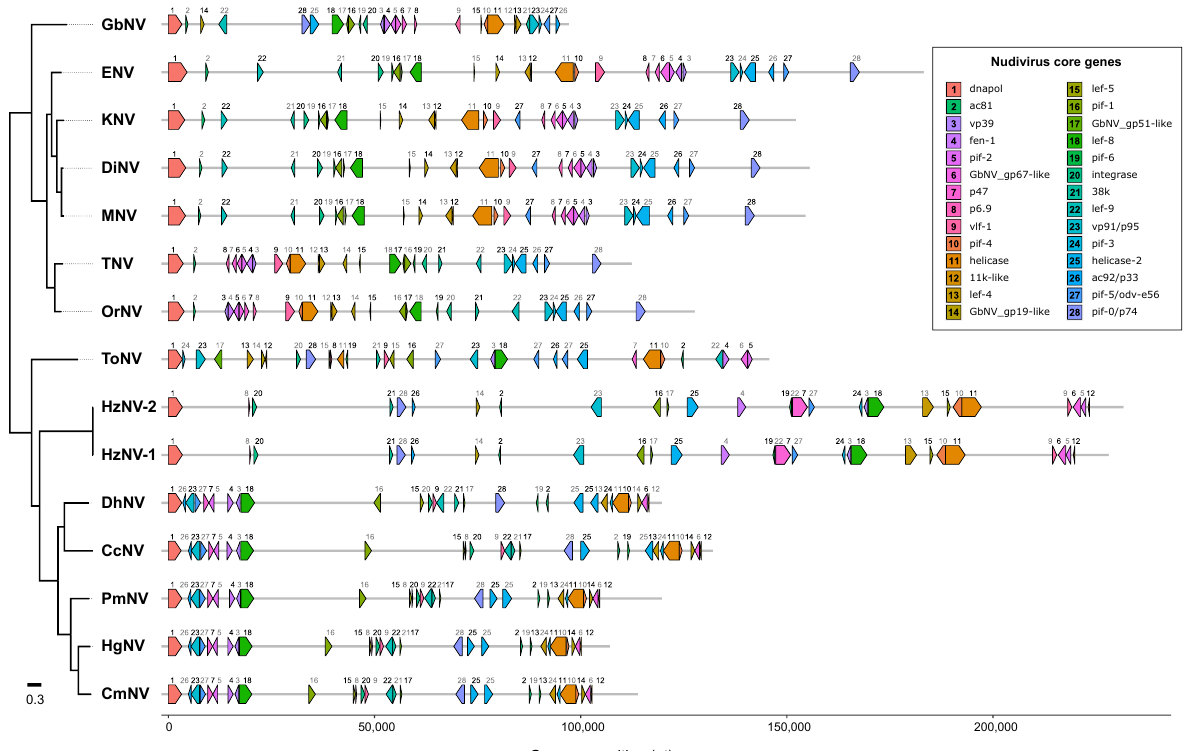
Figure 4. Genome map of 15 nudiviruses showing the position of 28 core genes. Open reading frames (ORFs) are shown as arrows, which indicate the gene position and orientation in the genome. Grey lines represent the full length (nt) of the genomes. The genome sequences were rearranged, such that all linear representations of the circular viral genomes start with the DNA polymerase gene. The genome map was created using the R package gggenes and combined with the phylogenetic tree shown in Figure 3B using